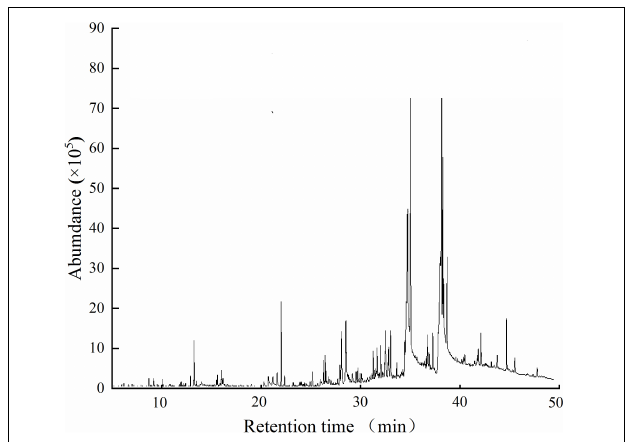
FIGURE 1 | Total ion flow graph of sweet potato petroleum ether